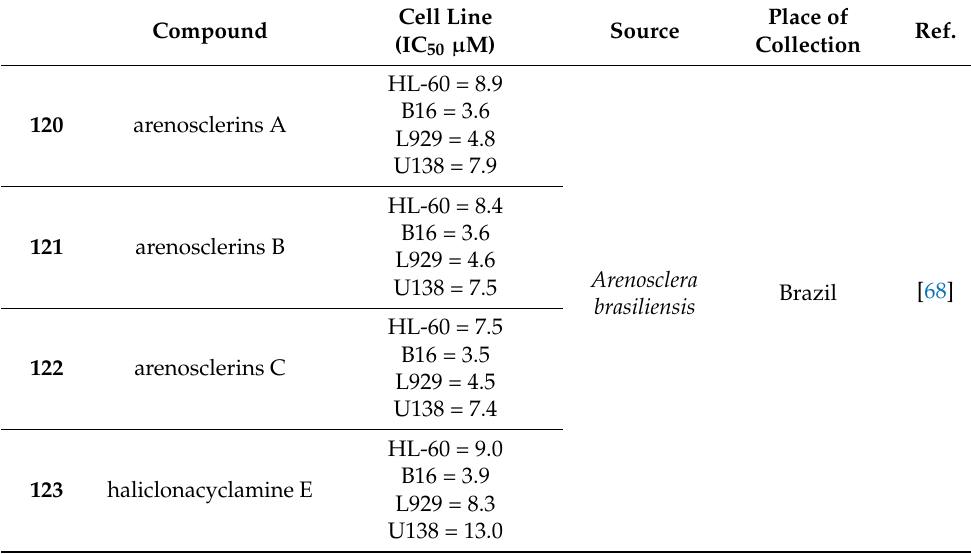
Figure 10. Piperidine alkaloid structure in marine sponges. Table 10. Cytotoxic activity of piperidine